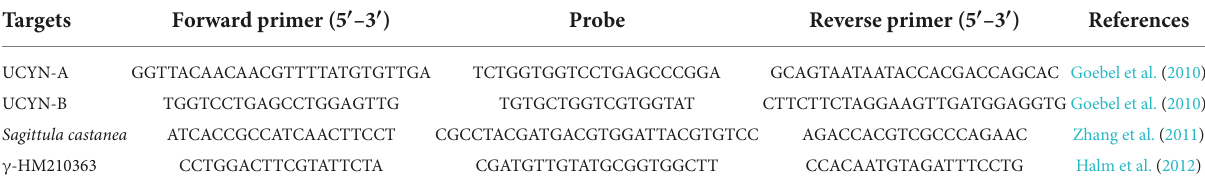
TABLE 1 Primers, Taqman probes, and standard clones for quantitative polymerase chain reaction (qPCR) analysis targeting the nif H gene of different cyanobacterial diazotrophic